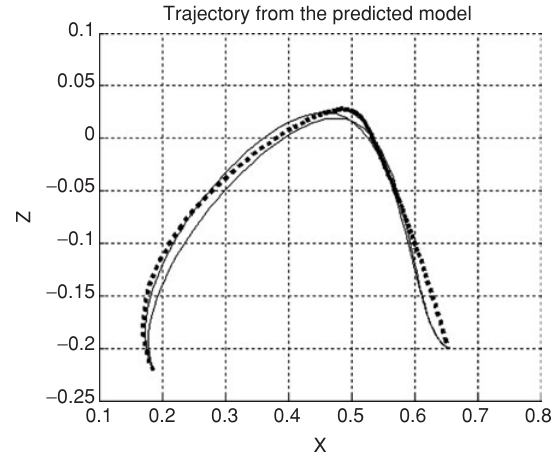
Figure 17 Simulated trajectory.